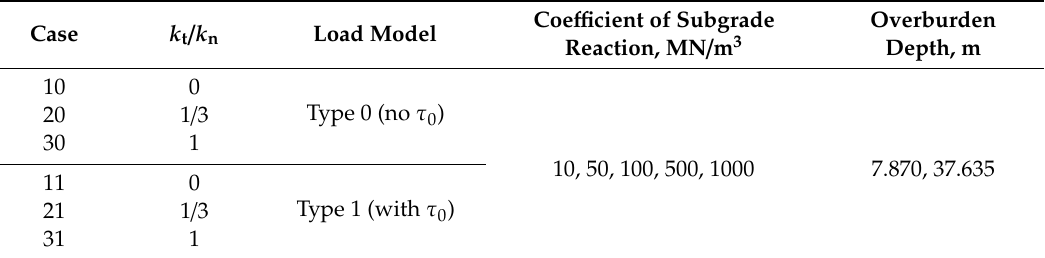
Table 2. Analysis cases of the parameter study.